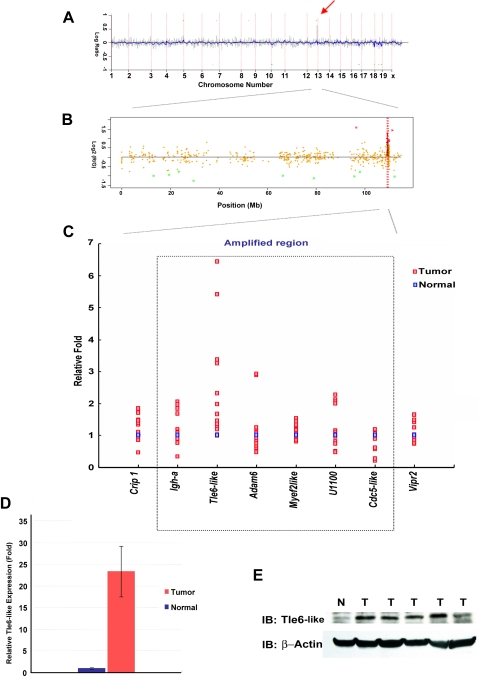
Array-CGH analysis of Mlh3;Pms2;Apc deficient GI tumors.(A) Display of CGH signal from a representative tumor genome wide. Red arrow indicates the gain of signal on chromosome 12. (B) Higher resolution view of mouse chromosome 12 signal. Red dot line indicates the amplification. (C) Quantitative PCR of genomic DNA level from MPA tumors. Dotted box indicates the amplified region detected by array-CGH. (D) Quantitative PCR of Tle6-like level in cDNA from MPA tumors. (E) Immunoblot of Tle6-like in MPA tumors. N, normal tissues; T, tumors.